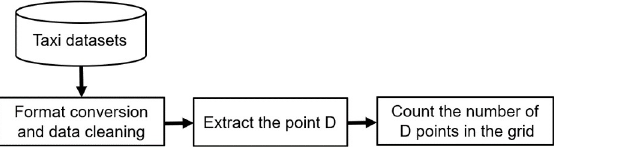
Fig 3. The calculation process of taxi travel demand.